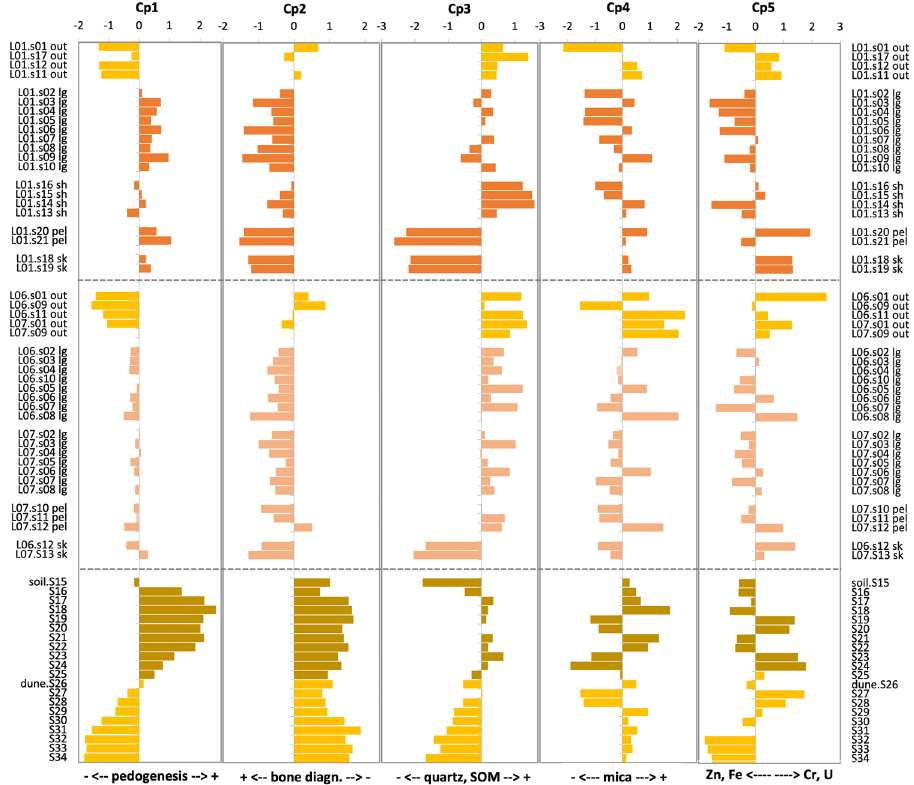
Figure 4. PCA scores of the analysed samples (burials, Ab-soil, and dune-C horizon), for the five main principal components. The burial samples have been grouped according to the place they were taken ( out outside the burial), the transect ( lg longitudinal) and the anatomical region ( sk skull, sh shoulders, pel pelvis) with which they were